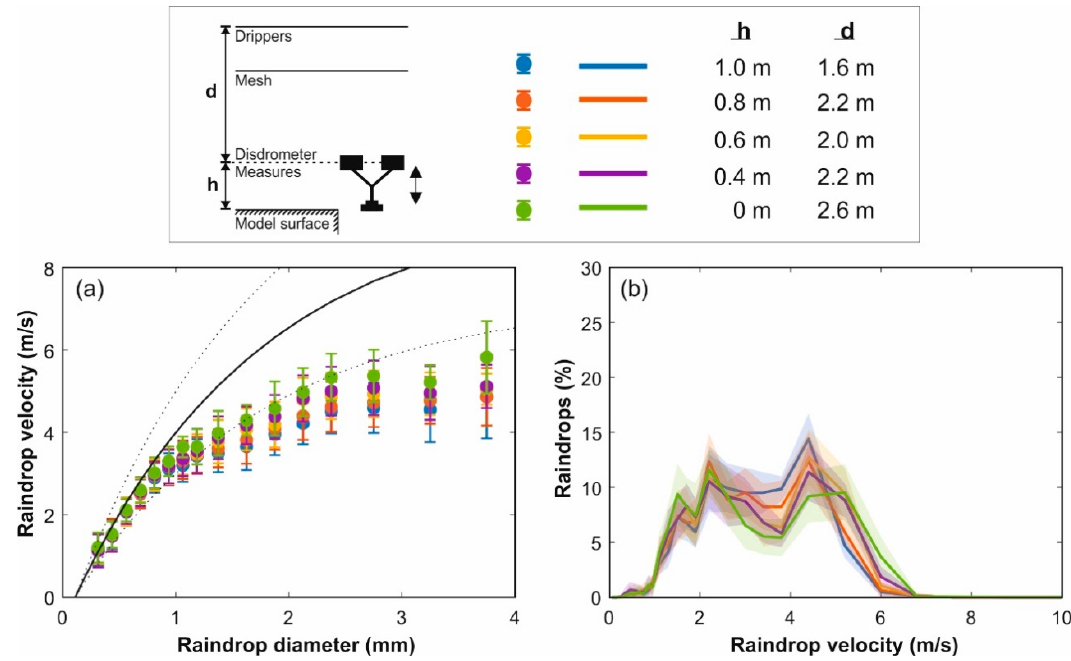
Figure 9. ( a ) Mean velocity of simulated raindrops for each diameter class and considering different measuring heights. Velocity errors represent standard deviation. The experimental relation between diameter and terminal velocity [37] was represented by the solid and dots (±25%) curves. ( b ) Raindrop velocity distributions for different measuring heights. Contours represents standard deviation of disdrometer measurements.